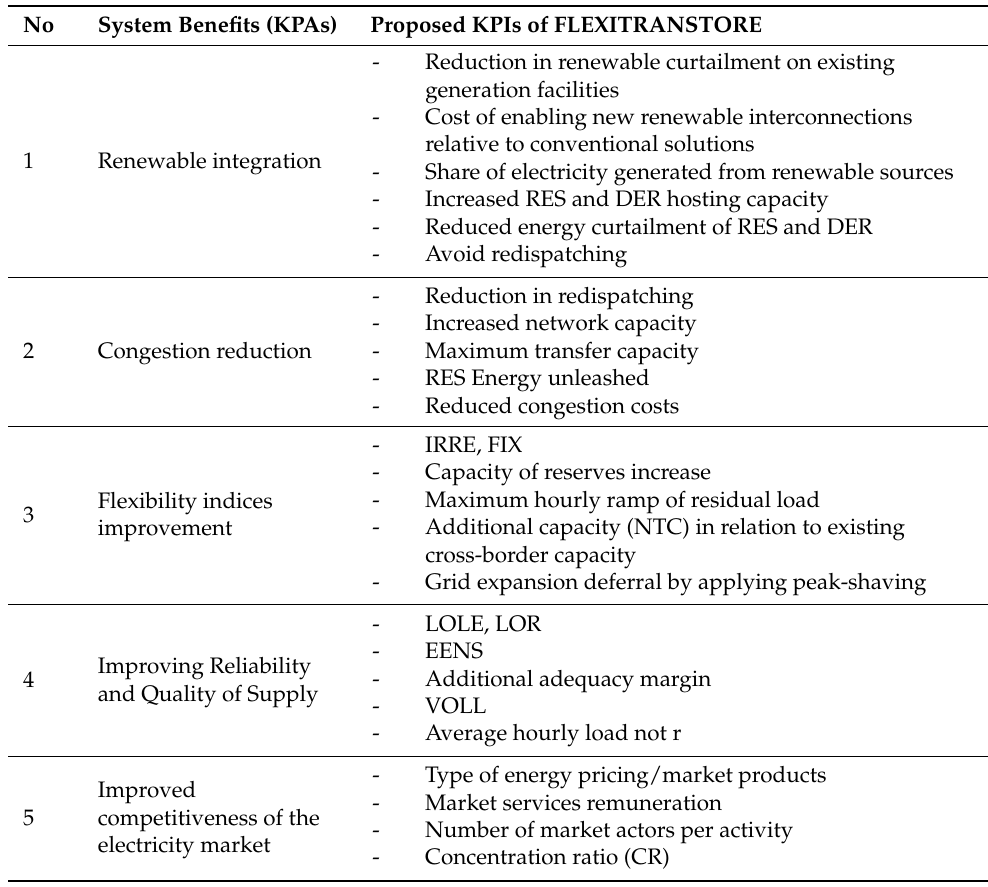
Table 1. Proposed KPIs to be used in the FLEXITRANSTORE project.